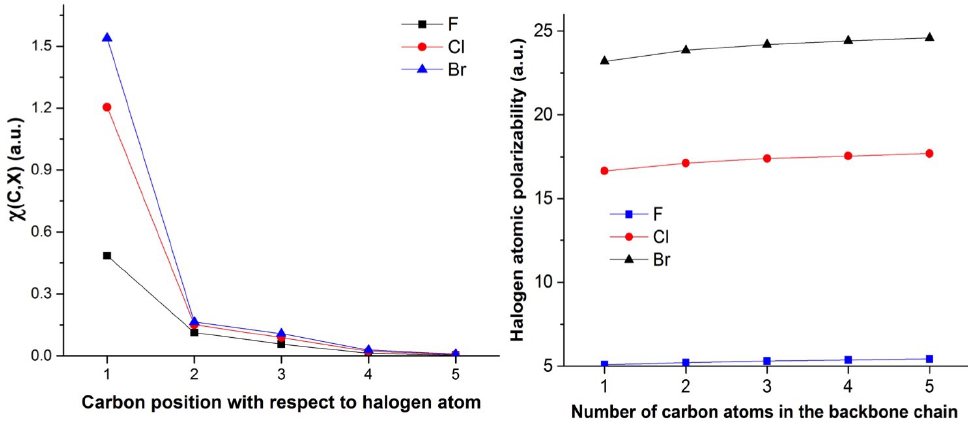
Figure 5. Left : Evolution for the QTAIM-condensed linear response kernel between halogen and the various carbon atoms. Right : Evolution of the atomic polarisability for halogen atom with respect to the alkyl chain